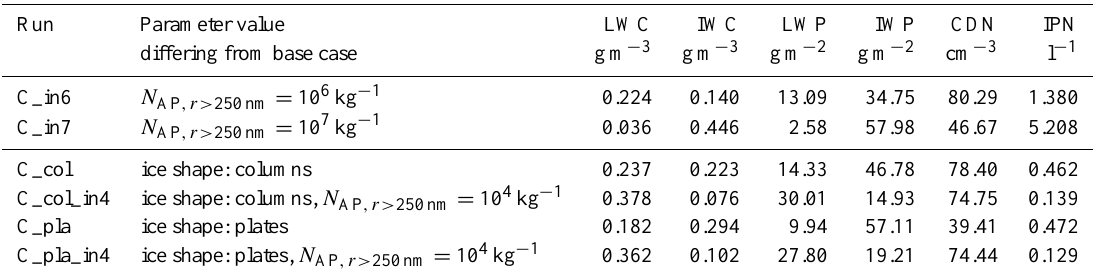
Figure 18. LWC (contours) and IWC per bin (colors, both logarithmic scale) for case 1 (upper panel) and case 2 (lower panel) for the respective base case (left) and the case with enhanced IN number (right; in6) after 16 and 17 minutes model time, respectively, corresponding to the IWP maximum of the base case runs. Table 4. Overview of the model results for the microphysical sensitivity runs for the colder case 2 (maximum values of L/IWC: liquid/ice water content; L/IWP: liquid/ice water path; CDN: cloud drop number; IPN: ice particle